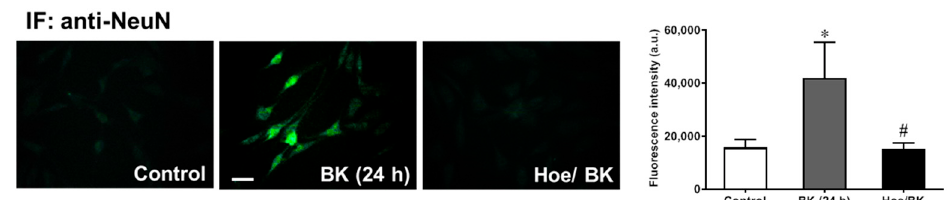
Figure A1. BK induces neuronal nuclear protein (NeuN) expression in RBA. The upregulation of NeuN by BK was confirmed by immunofluorescence in RBA. Cells were pretreated with Hoe140 (Hoe, 10 µ M) for 1 h and then incubated with BK (10 nM) for 24 h. After treatment, the cells were labeled using an anti-NeuN antibody and a FITC-conjugated secondary antibody. Individual cells were imaged (scale bar = 20 µ m) as described in “Methods”. The fluorescence intensity (arbitrary units: a.u.) of NeuN was quantified in these cells. * p < 0.05, as compared with control. # p < 0.05, as compared with BK alone.